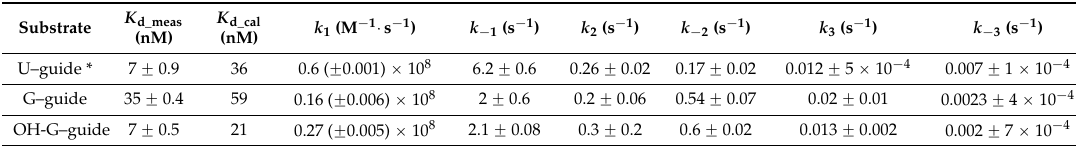
Table 3. Summary of equilibrium and pre-steady-state binding data for hAgo2/G–guide RNA complex formation. Numbers in the first row represent equilibrium measurements ( K d_meas ). Numbers in the second column were calculated from the corresponding association and dissociation rate constants ( K d_cal = k off / k on = ( k − 1 / k 1 ) × ( k − 2 / k 2 ) × ( k − 3 / k 3 )). Differences in K d values for binary complexes